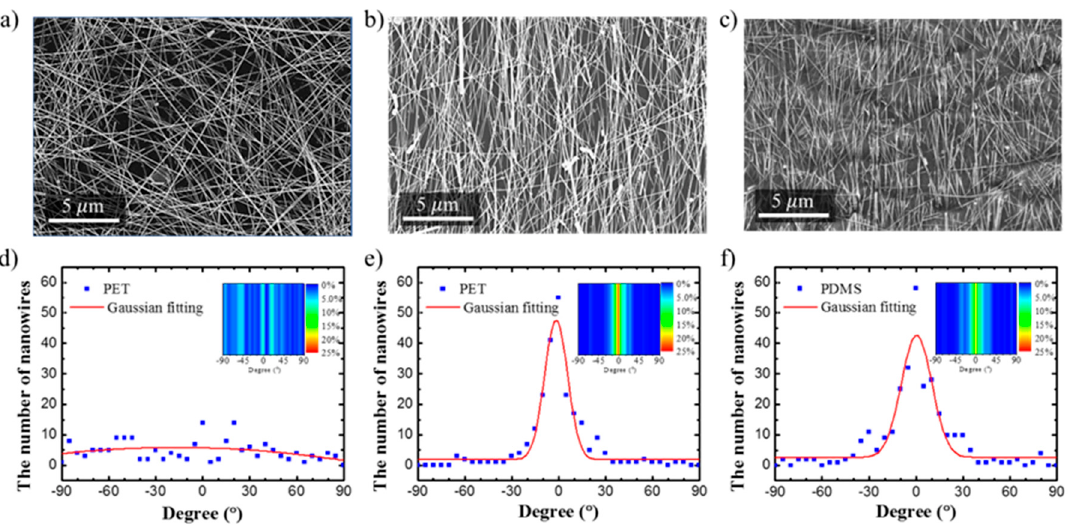
Figure 4. Comparison of the degree of alignment of silver nanowires. ( a ) SEM image of unaligned silver nanowires. ( b ) SEM image of the silver nanowires aligned using the temperature-controlled dip coating process. ( c ) SEM image of the silver nanowires transferred to the PDMS. ( d ) Analysis of the degree of alignment of unaligned silver nanowires. ( e ) Analysis of the degree of alignment of silver nanowires aligned using the temperature-controlled dip coating process. ( f ) Analysis of the degree of alignment of the transferred silver nanowires. Insets of ( d – f ) show the distribution of nanowires according to the angle, and the amount of silver nanowires is expressed in